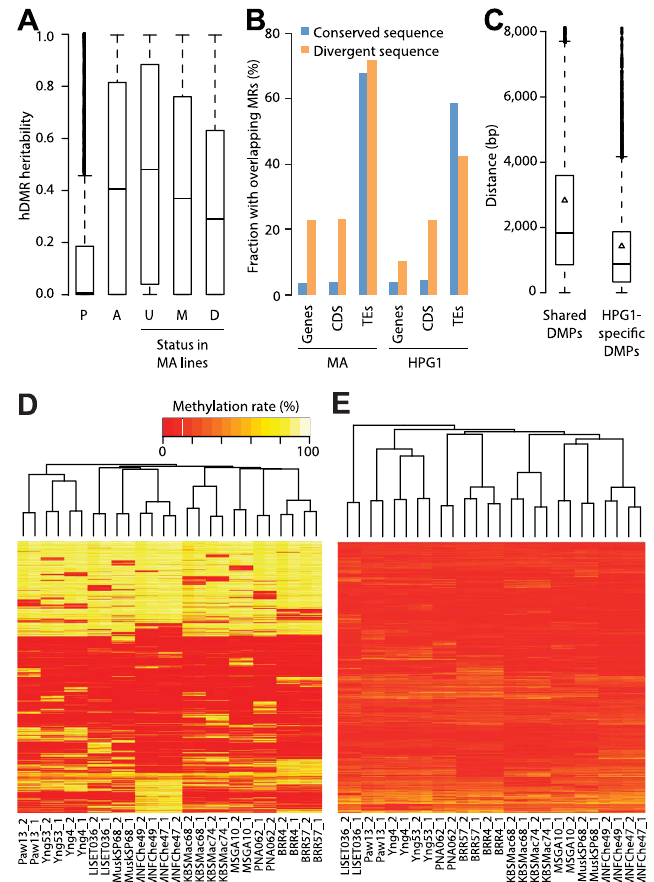
Fig. 4. Genetic effects on epigenetic variation. (A) Heritability values based on genome-wide genetic differentiation for all highly differentially methylated regions (hDMRs), hDMRs with randomly permuted methylation rates and subsets of hDMRs depending on their overlap with methylated and differentially methylated regions of the mutation accumulation (MA) population, respectively. P: Permuted (2,945 hDMRs); A: All (2,945); U: Unmethylated in MA (1,310); M: Methylated in MA (1,243); D: DMR in MA (392). (B) Correlation between structural variants (SVs) and probability of overlap with methylated regions (MRs). Divergent sequences are insertions of at least 20 bp relative to the other population. This analysis is based on 3,256 SVs overlapping with genes, 641 with coding sequences (CDS) and 4,020 with transposable elements (TEs) (S12 Table). (C) Distances between common SVs of at least 20 bp and the closest differentially methylated position (DMP), depending on whether it is shared between the mutation accumulation (MA) and haplogroup-1 (HPG1) populations. Triangles represent the mean. (D) Hierarchical clustering of HPG1 strains based on methylation rates at 50,000 CG-DMPs. (E) Hierarchical clustering of HPG1 strains based on average methylation rates of 2,829 hDMRs with full information across all strains. Methylation rates per region were calculated as the average methylation rate of each methylated cytosine in that region.